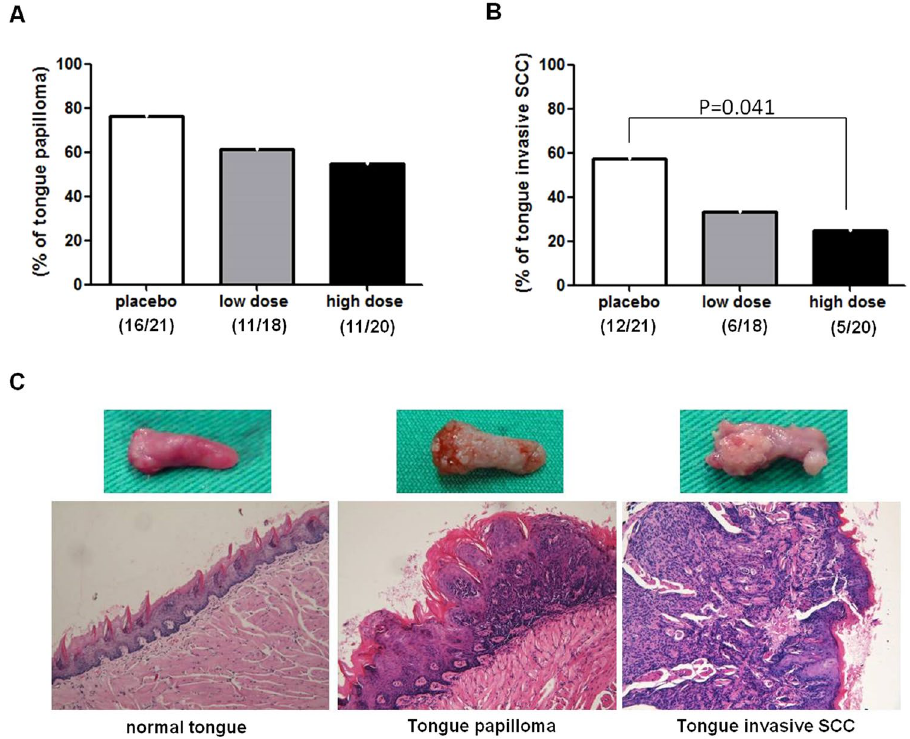
Figure 4. Inhibitory effect of the mTOR inhibitor, everolimus, in 4-NQO-induced tongue cancer murine model. ( A ) The incidence of tongue papilloma in mice treated with placebo, low dose everolimus, and high dose everolimus. There were no significant differences in papilloma between three groups. ( B ) The incidence of tongue SCC in mice treated with placebo, low dose everolimus, and high dose everolimus. Mice in high dose everolimus group developed significantly (P = 0.041) less invasive SCC than those in vehicle group. ( C ) Gross appearance and hematoxylin and eosin stained ( H and E ) sections of normal tongue, tongue papilloma, and tongue SCC from representative mice. Original magnification × 200. SCC: squamous cell